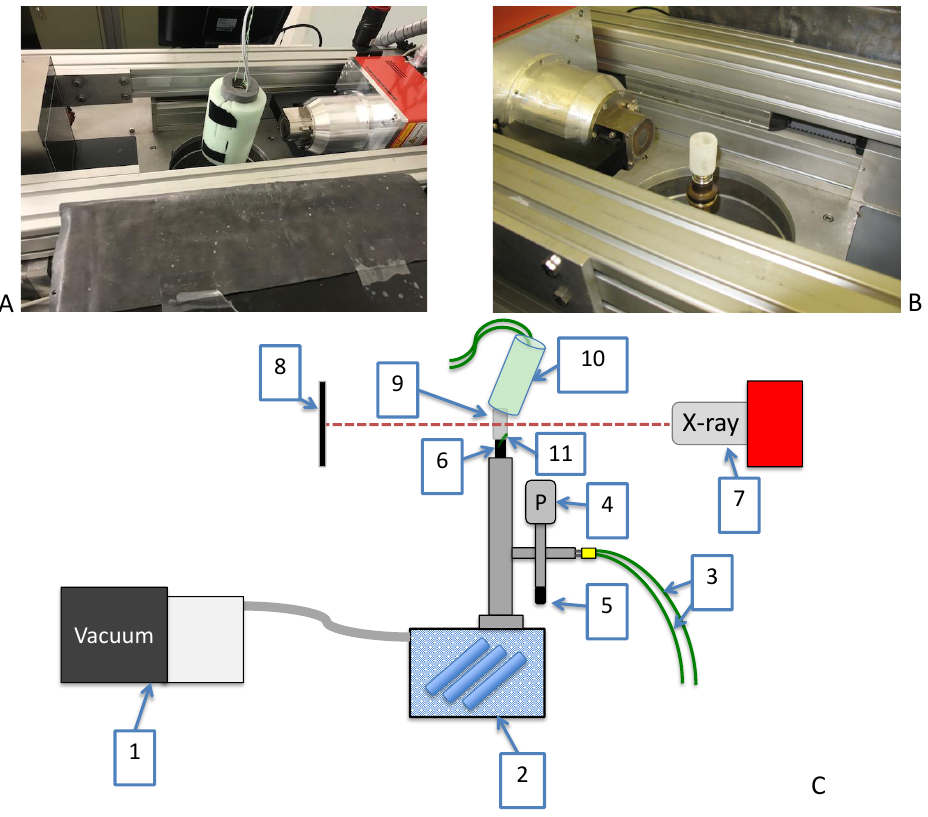
Figure 2. ( A ) µ CT set-up with spin-frozen vial wrapped with insulating fabric surrounded by X-ray source and detector. ( B ) Spin-frozen vial without insulation (merely to illustrate the positioning of the vial). ( C ) 1: Vacuum pump; 2: Condenser; 3: Frozen product thermocouple read-out; 4: Proportional pressure valve; 5: Pirani gauge; 6: Vial manifold 7: X-ray source; 8: Detector; 9: Spin-frozen vial; 10: Heating pad wrapped with insulating fabric.; 11: thermocouple located inside vial at vial